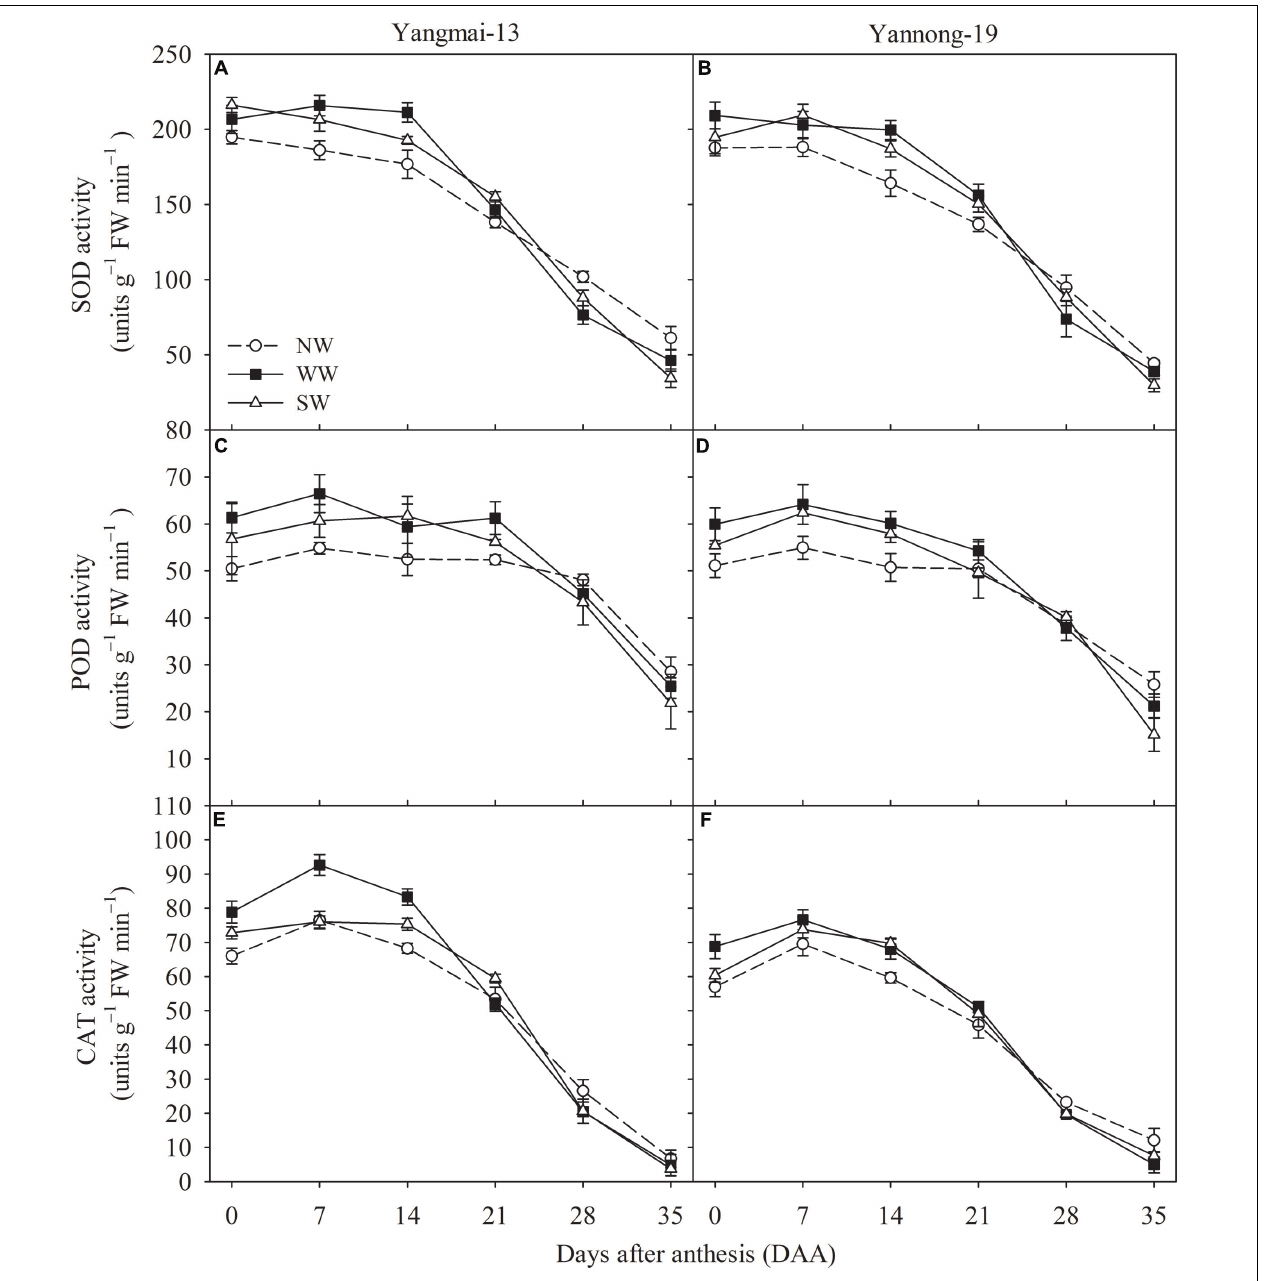
FIGURE 5 | Activities of superoxide dismutase (SOD), peroxidase (POD), and catalase (CAT) as affected by winter (WW) and spring (SW) night-warming in the flag leaves of Yangmai-13 (A,C,E) and Yannong-19 (B,D,F) after anthesis during 2013–2014. NW refers to the no warming control. The data are the means ± SE ( n =